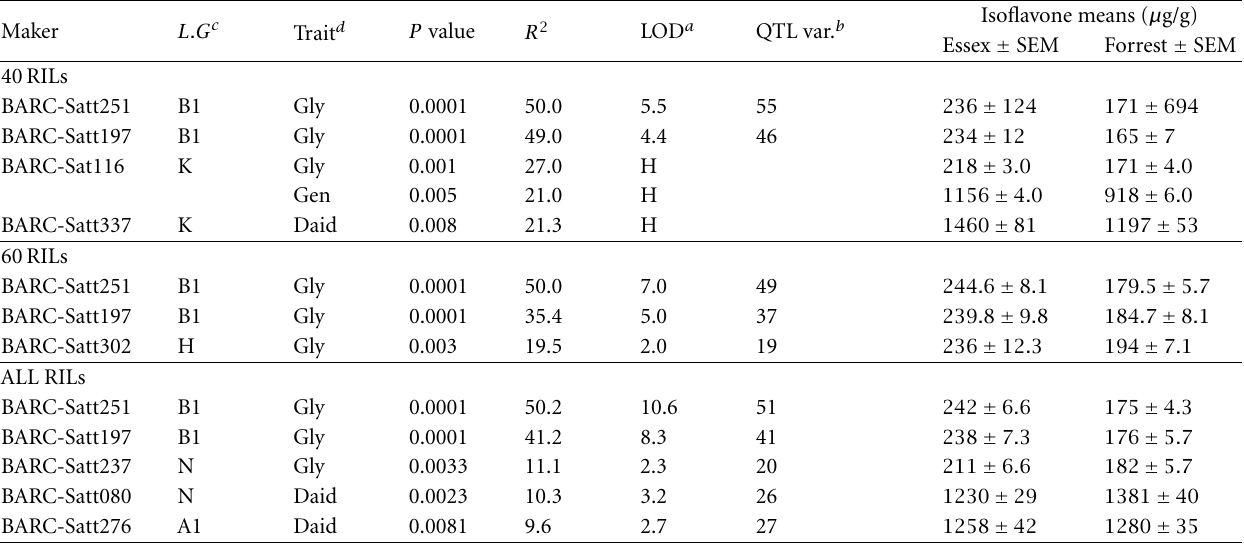
Table 1: Chromosomal regions associated with Isoflavone content of the soybean seed in Essex × Forrest recombinant inbred lines.